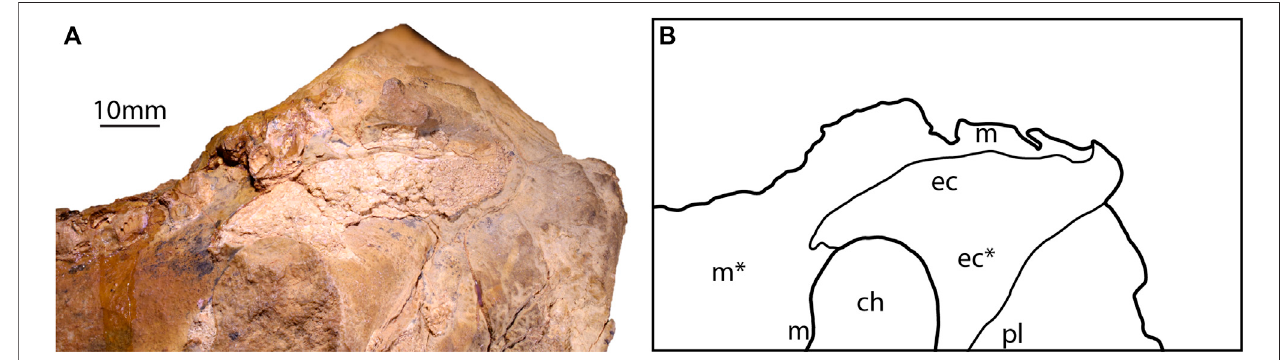
FIGURE 6 | Scarf joint between the right ectopterygoid and right maxilla of SAMA P40536. (A) Dorsolateral view of the physical specimen. (B) A line drawing showing the contact between the ectopterygoid and the maxilla. Abbreviations: ch, choanae; ec, ectopterygoid; m, maxilla; pl, palatine. Regions based on impressions are denoted with an asterisk (*).